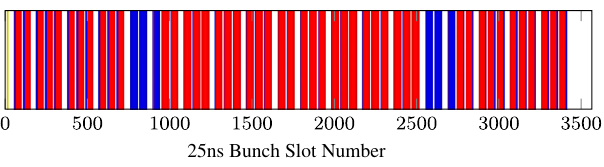
FIG. 14. The 2556 bunch filling scheme used for LHC beam 1 in 2017 proton physics operation. Apart from the 12 noncolliding bunches (yellow), the filling scheme for beam 2 is identical. Bunches in blue are not colliding in the ALICE or LHCb